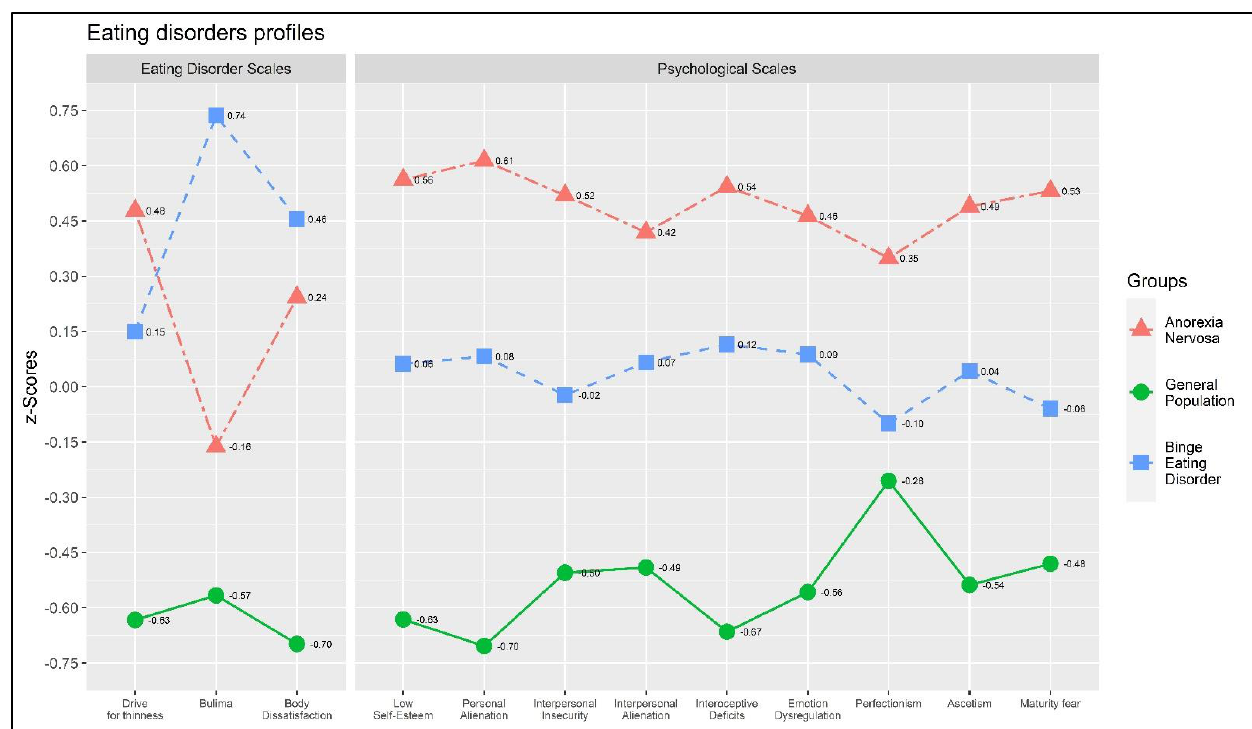
Figure 1. The plot of the profile analysis. Note : Eating disorder scales: Drive for Thinness—DT; Bulimia—B; and Body Dissatisfaction—BD. General psychological scales: Low Self-Esteem—LSE; Personal Alienation—PA; Interpersonal Insecurity—II; Interpersonal Alienation—IA; Interoceptive Deficits—ID; Emotional Dysregulation—ED; Perfectionism—P; Asceticism—A; Maturity Fears— MF. Participants with anorexia nervosa: n = 142; participants with binge eating disorder: n = 139; participants from the general population: n = 140.